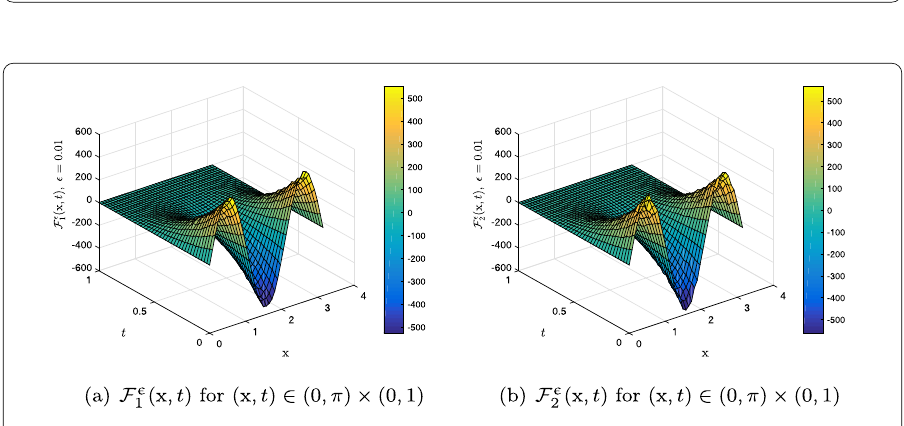
Figure 2 The source functions F ( x , t ) = F ( x ) Q ( t ), F ε 1 ( x , t ) = F 1, ε ( x , t ) ∈ (0, π ) × (0,1), ε = 0.1, α = β = 0.9